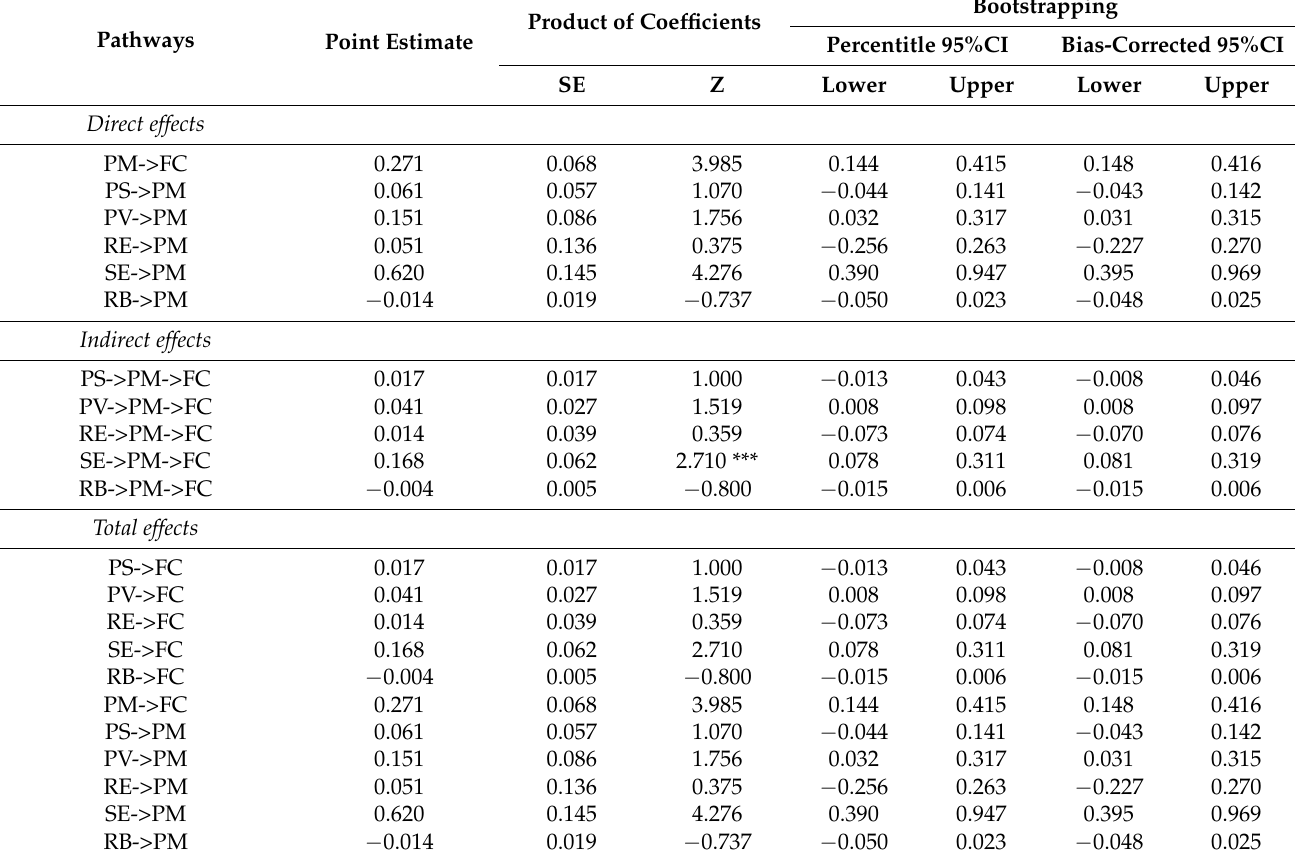
Table 6. Direct, indirect, and total effects of the hypothesized